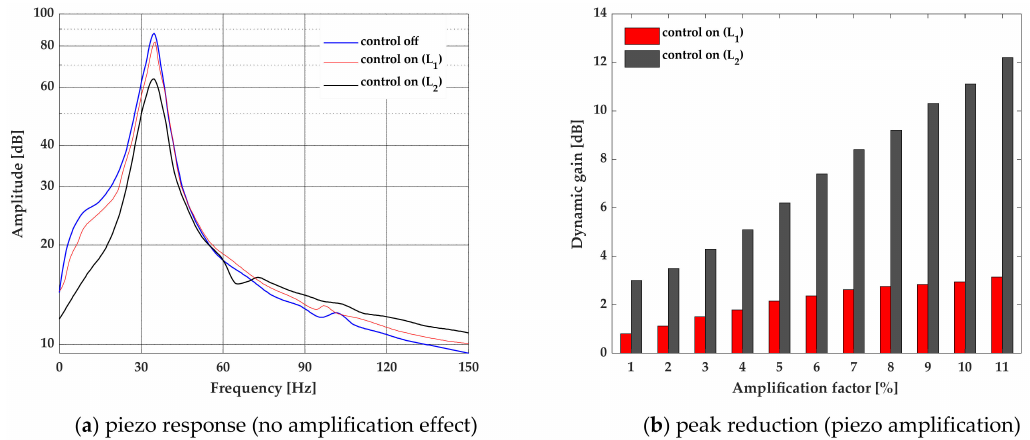
Figure 14. Vibration test performing: laser vibrometer